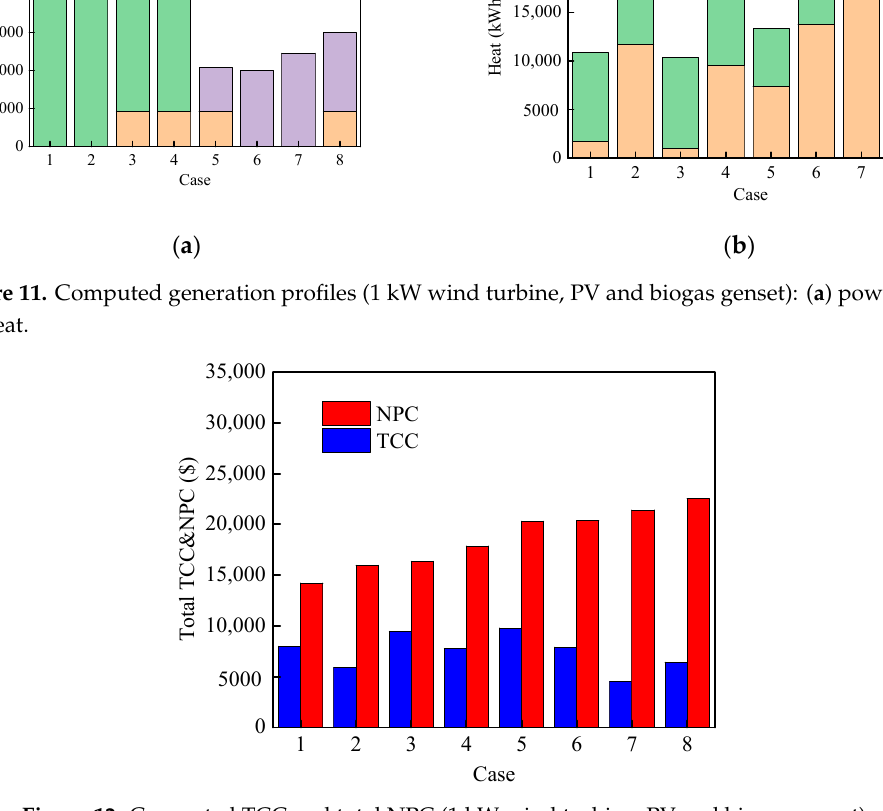
Figure 12. Computed TCC and total NPC (1 kW wind turbine, PV and biogas genset).